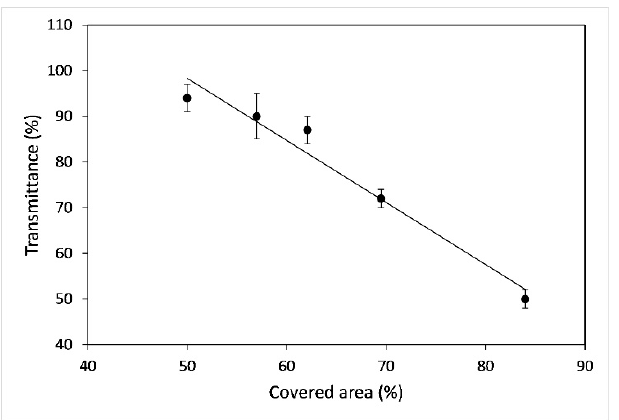
Figure 8. Transmittance % as a function of the % of covered area for superhydrophobic samples. Data acquired at the wavelength of 350 nm. (The black line is a trend line).